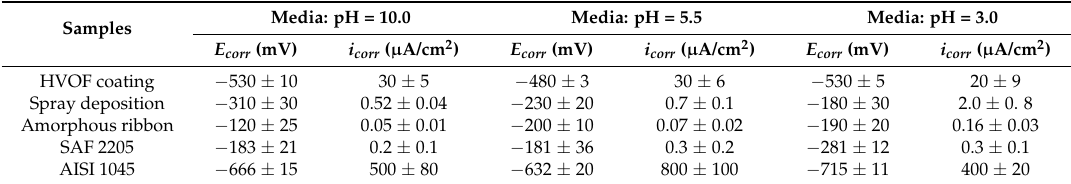
were also observed along the anodic polarization of the amorphous ribbons, but no stable pitting was induced even for polarizations as large as +0.6 V. Corrosion properties of 63.5Fe25Cr7Ni4.5B samples obtained from potentiodynamic polarization curves for amorphous ribbons, coatings produced HVOF process and deposits from spray forming. Results of AISI 1045 steel and SAF 2205 added for comparison reasons. Potentials measured against the saturated calomel electrode (SCE) reference.